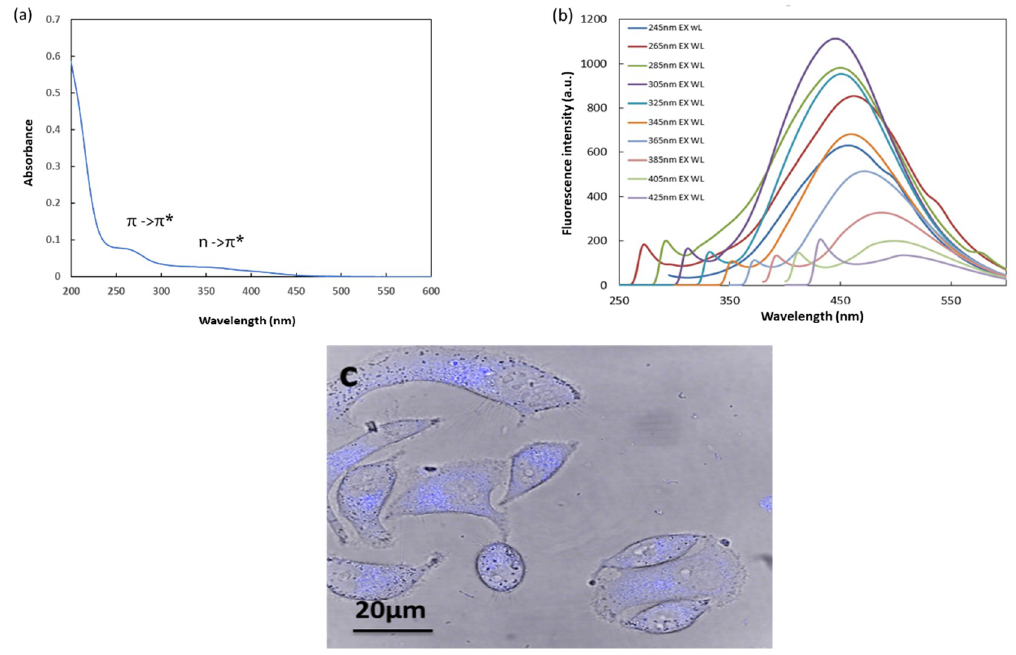
Figure 4. ( a ) UV-Vis absorbance spectrum of HFCNH and ( b ) fluorescence emission spectrum of HFCNH; ( c ) fluorescence image of HFCNH emits blue fluorescence in MDCK cells in vitro.